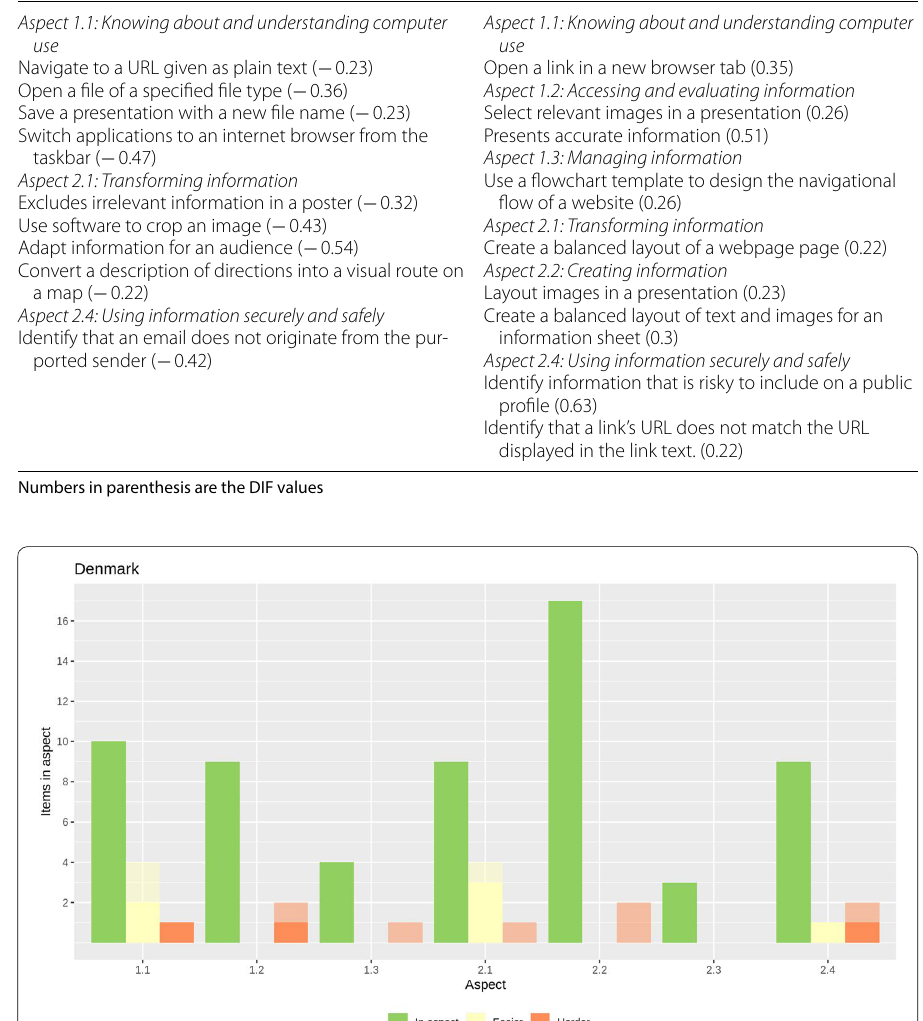
Table 2 Easier and harder items for Danish students Easier Harder Aspect 1.1: Knowing about and understanding computer use